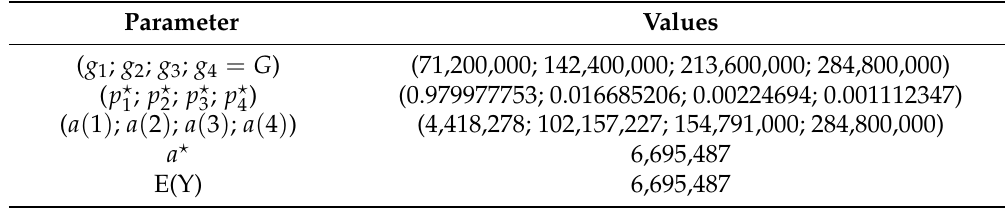
Table 6. 4-states Markov chain values for Group 2.